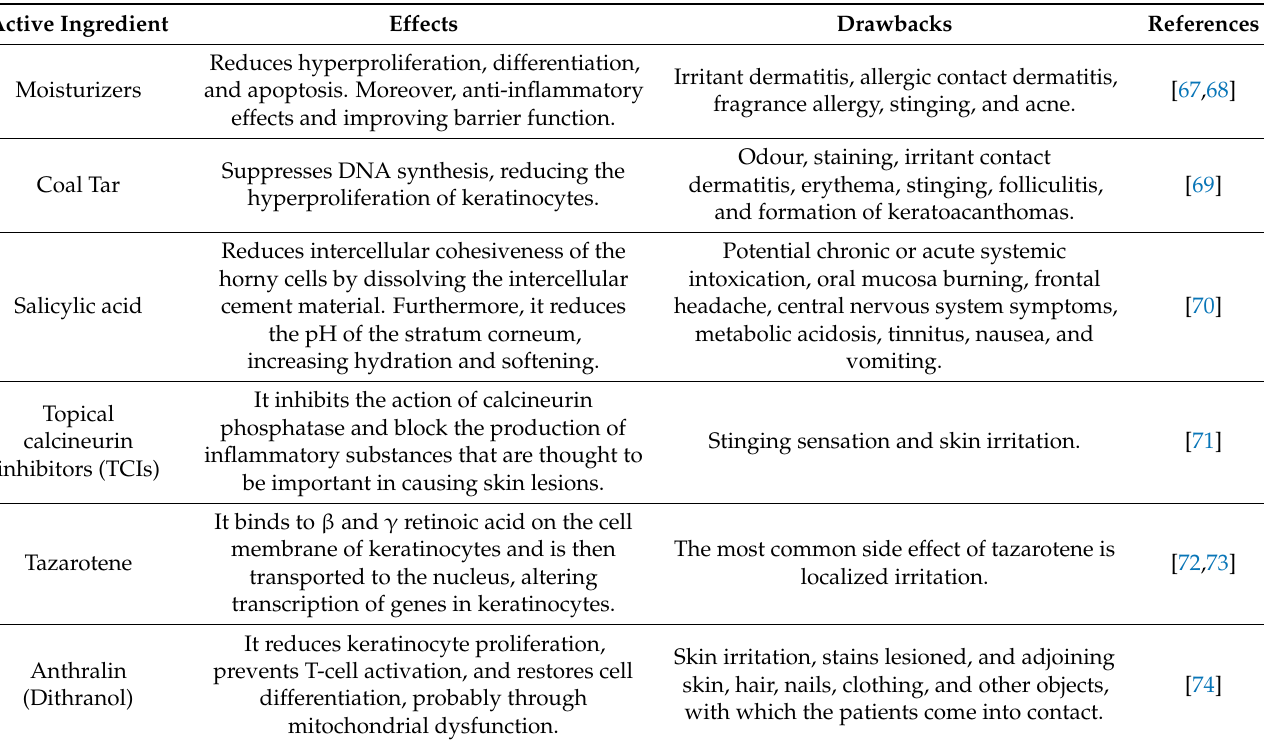
Table 1. Accepted topical treatments for